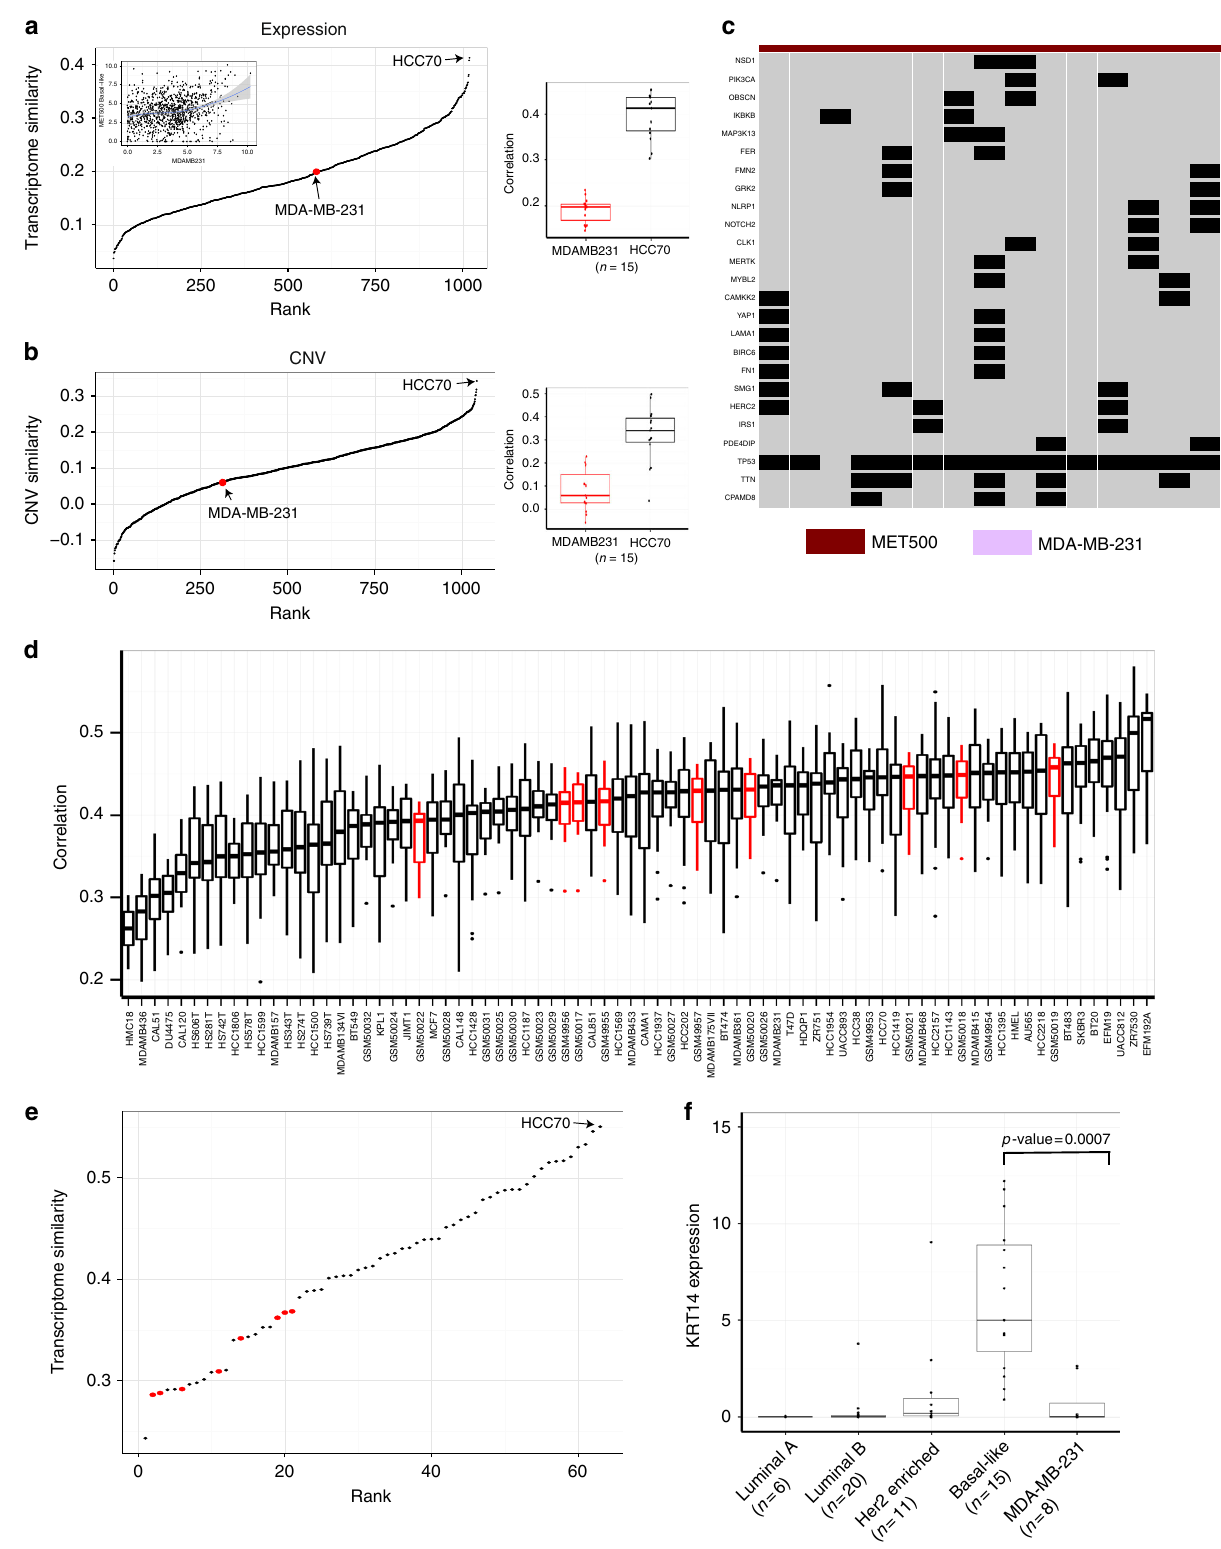
correlation with lung metastasis breast cancer samples was EFM192A (Fig. 4d). To further con fi rm the low transcriptome similarity of MDA- MB-231 with Basal-like MET500 breast cancer samples, we re- processed the RNA-Seq data of CCLE breast cancer cell